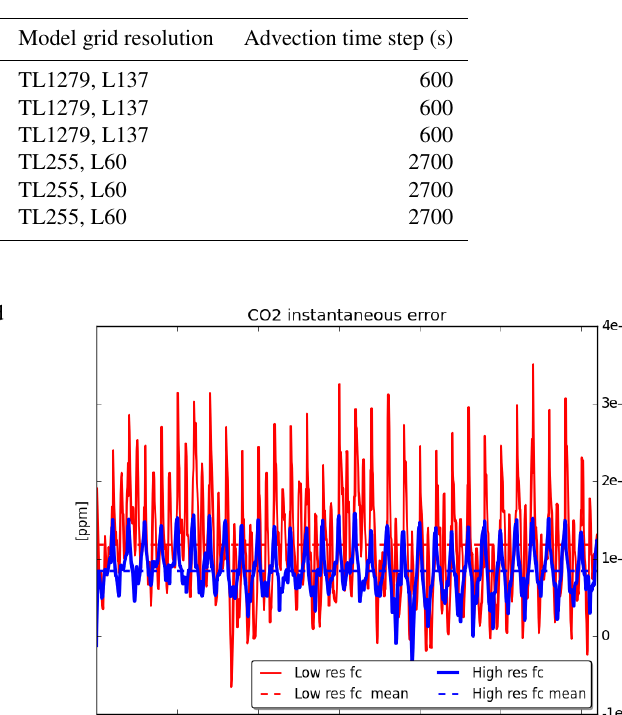
Table 1. List of simulations at different resolutions and with different mass fixers performed from 1 March 2013 to 30 April 2014.